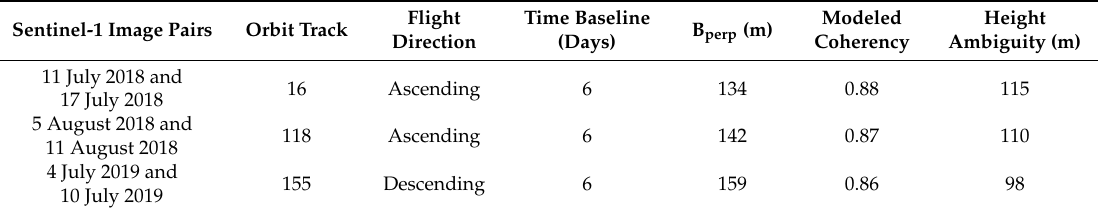
Table 2. Sentinel-1 data and their characteristics used to generate the digital elevation models (DEMs). The B perp stands for the spatial perpendicular baseline, which was used as the main criterion for the selection of Sentinel-1 A and B image pairs. The modeled coherency and height ambiguity measurements were derived using the interferometric synthetic aperture radar (SAR) (InSAR) stack overview function implemented in the Sentinel Application Platform (SNAP)